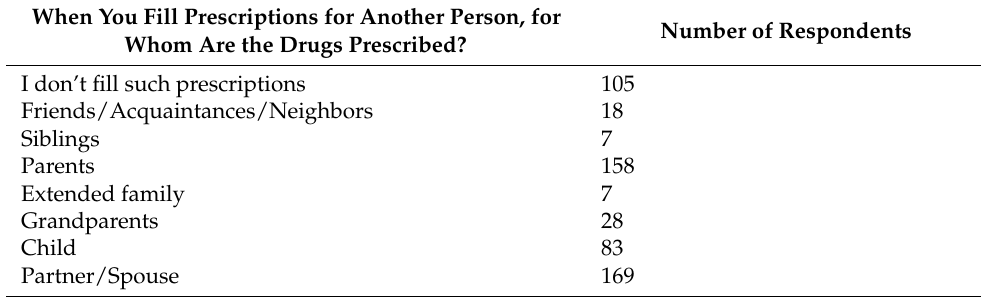
Table 3. Numerical summary of responses to the question: when you fill prescriptions for